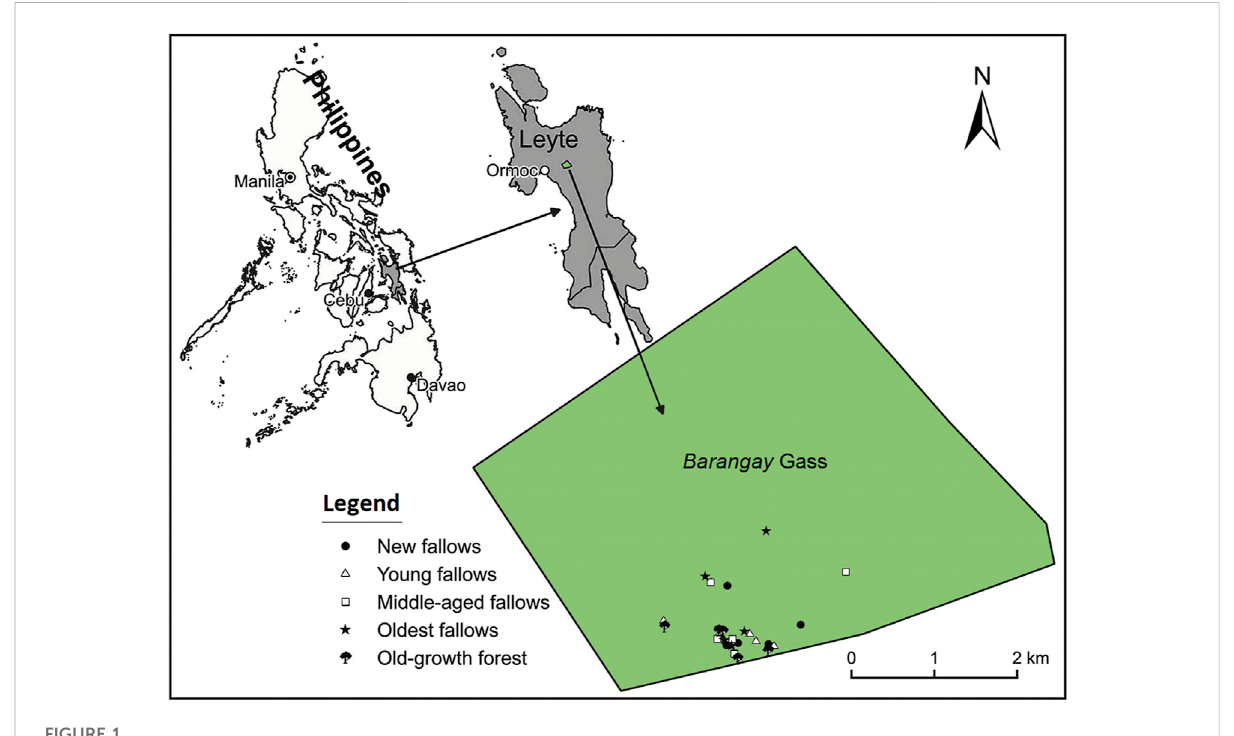
FIGURE 1 Location map of the study area on Leyte Island, the